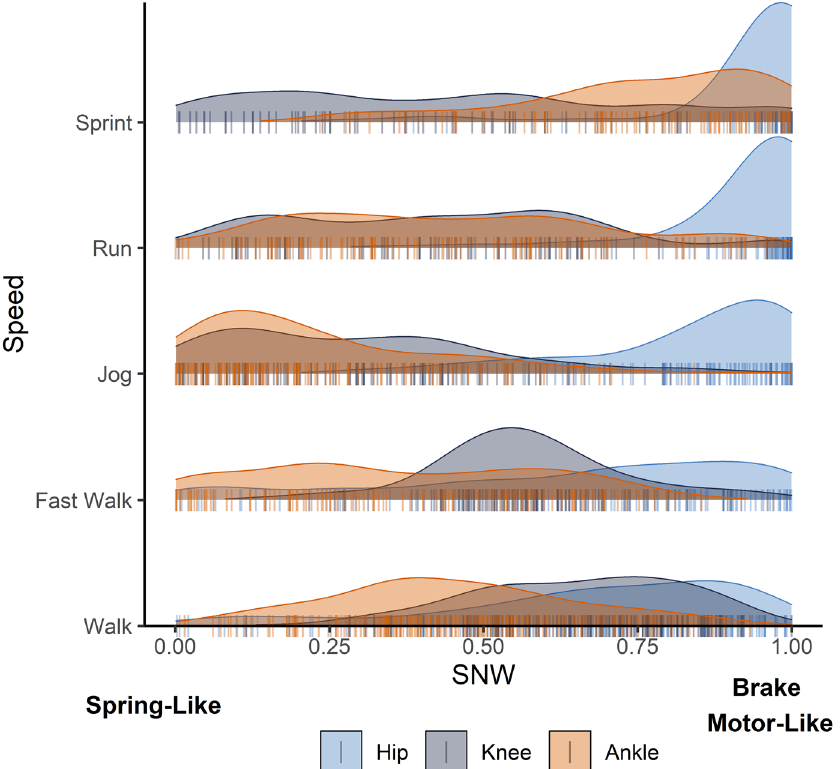
Figure 1. Density plot of individual specific net work (SNW) values for the hip, knee, and ankle for each step, for all subjects, at each speed. Peaks represent the most concentrated distribution of SNW values for each joint, at each speed. Plot rugs (vertical lines) are histograms of SNW values from all subjects and all steps.